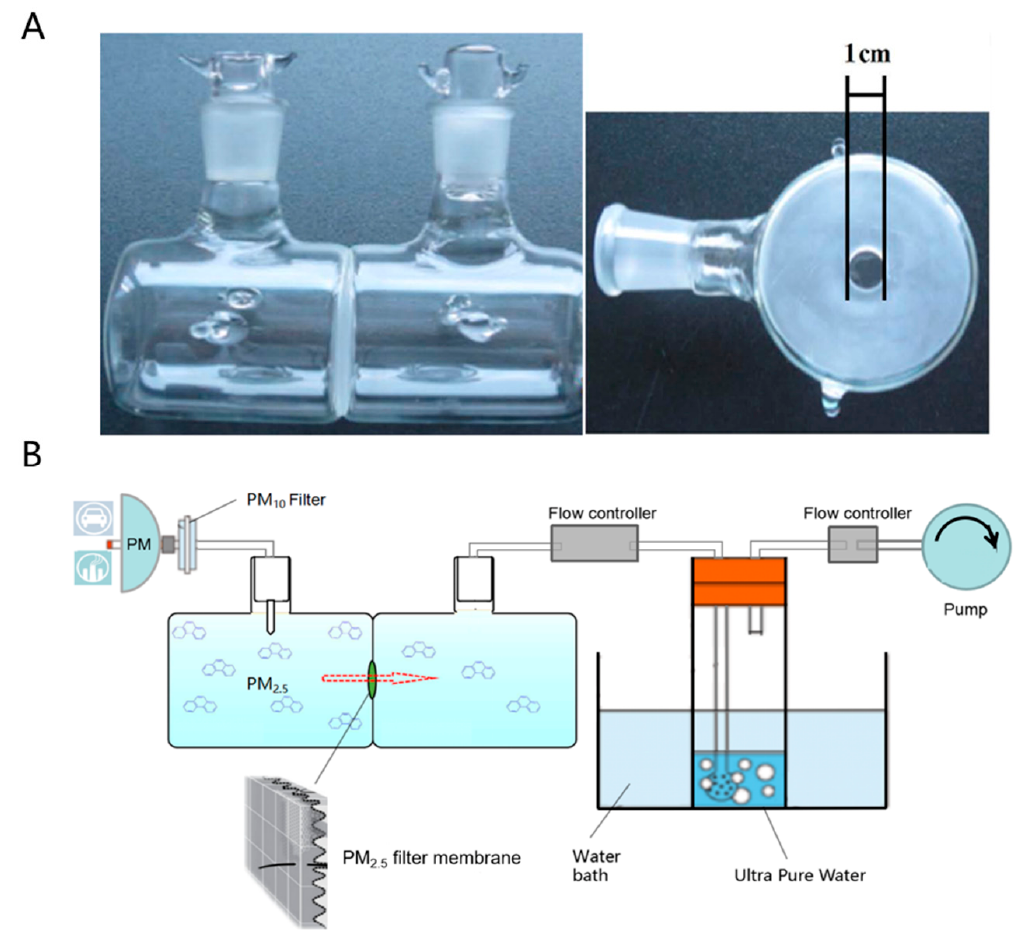
Figure 2. The collection device and process of atmospheric PM2.5. ( A ) The structure of PM2.5 ex- traction device. ( B ) PM2.5 extracts manufacturing process schematic diagram. extraction device. ( B ) PM2.5 extracts manufacturing process schematic